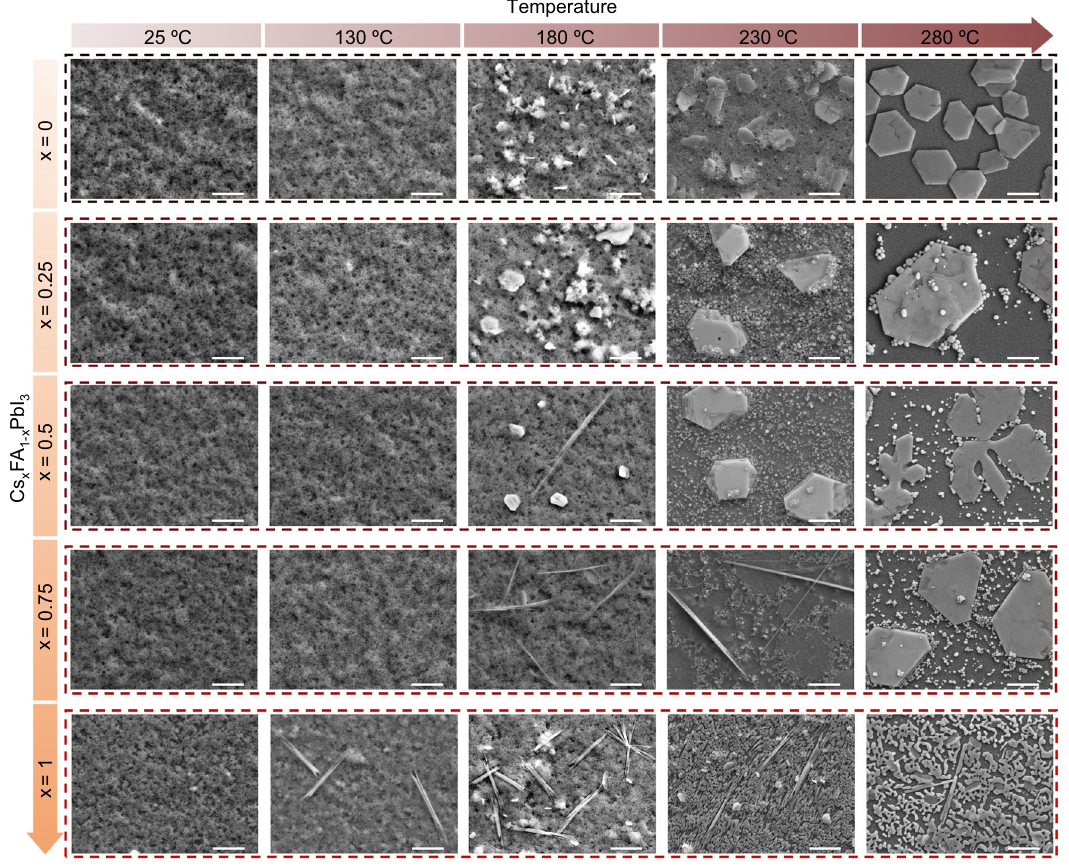
Fig. 2 | Morphology evolutions of Cs x FA 1-x PbI 3 PQDs during thermal degrada- tion process. SEM images of FAPbI 3 , Cs 0.25 FA 0.75 PbI 3 , Cs 0.5 FA 0.5 PbI 3 ,